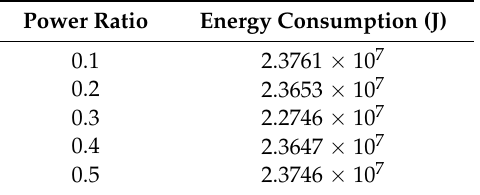
Table 3. The total consumed-energy for the front motor power ratio which was from 0.1 to 0.5.